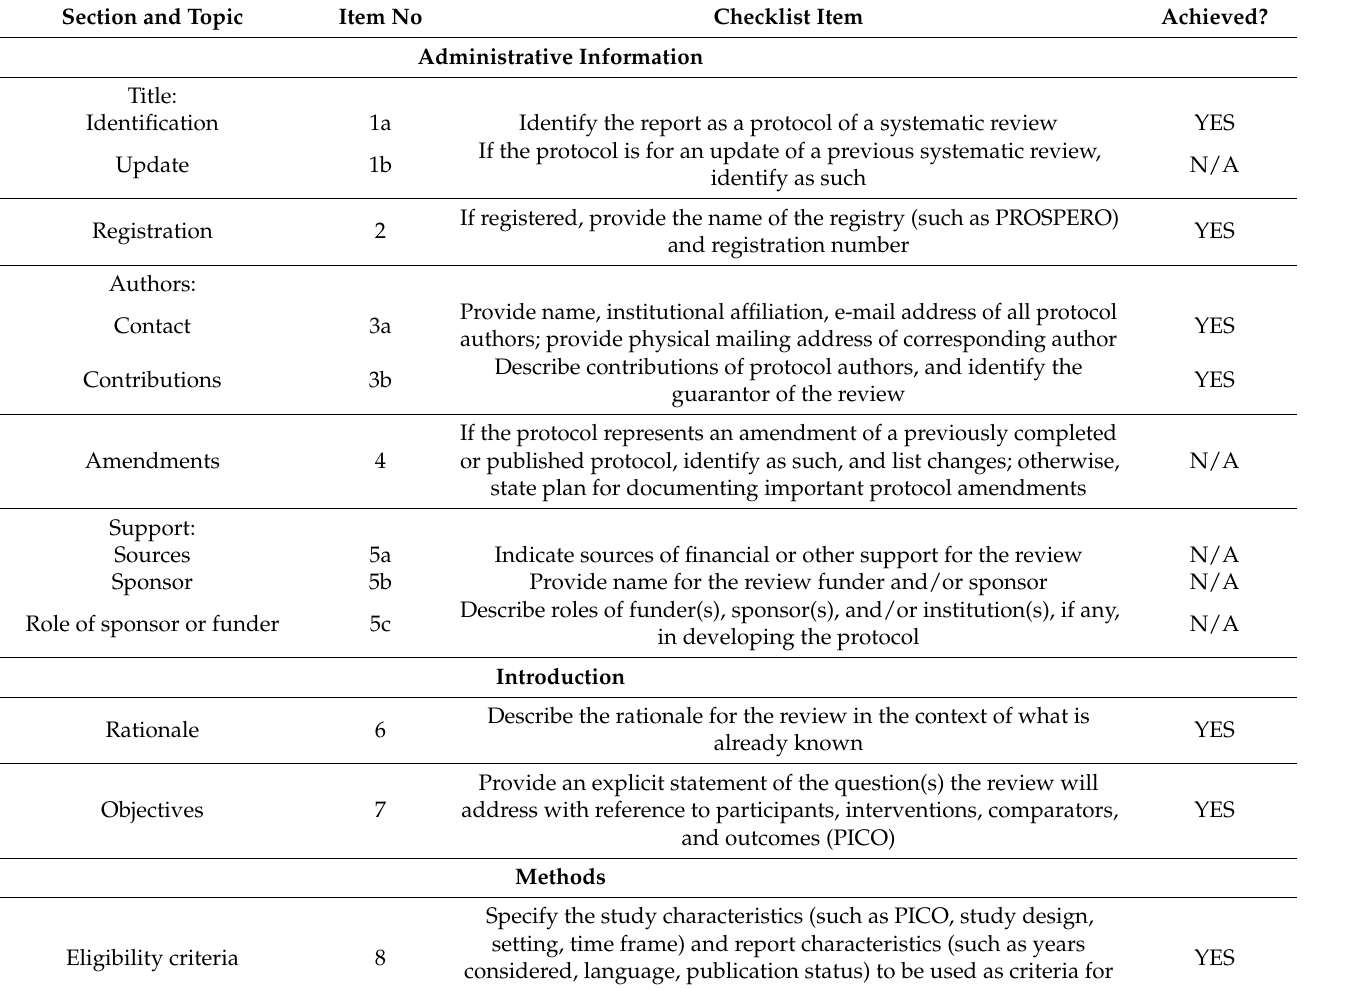
Table A1. PRISMA-P (Preferred Reporting Items for Systematic review and Meta-Analysis Protocols) 2015 checklist: recommended items to address in a systematic review protocol